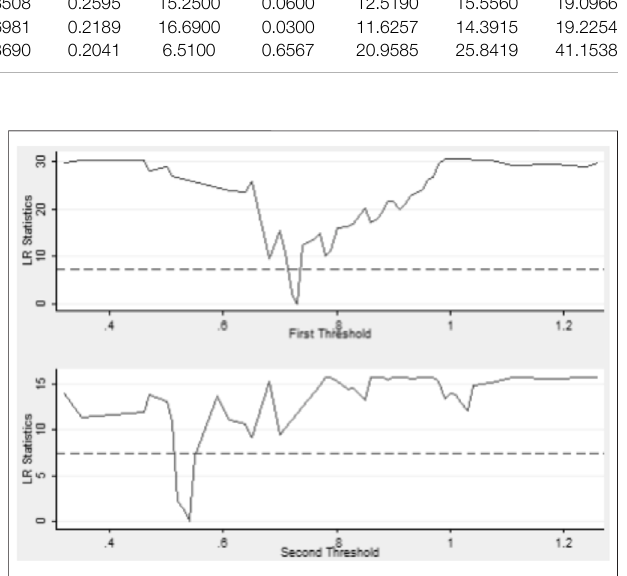
FIGURE 4 | Con fi dence interval diagram of the dual-threshold